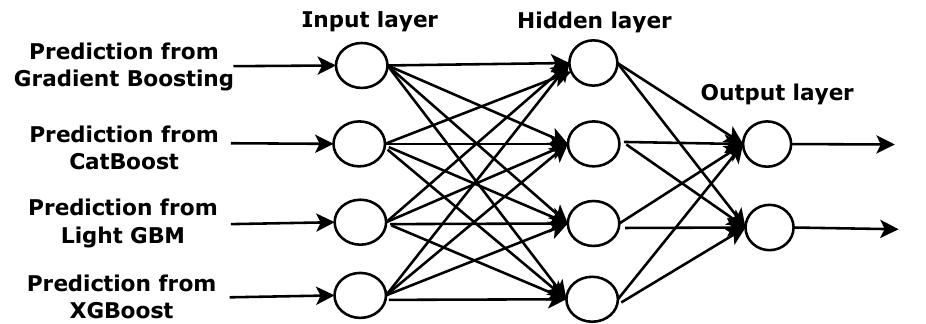
Figure 5. The structure of an artificial neural